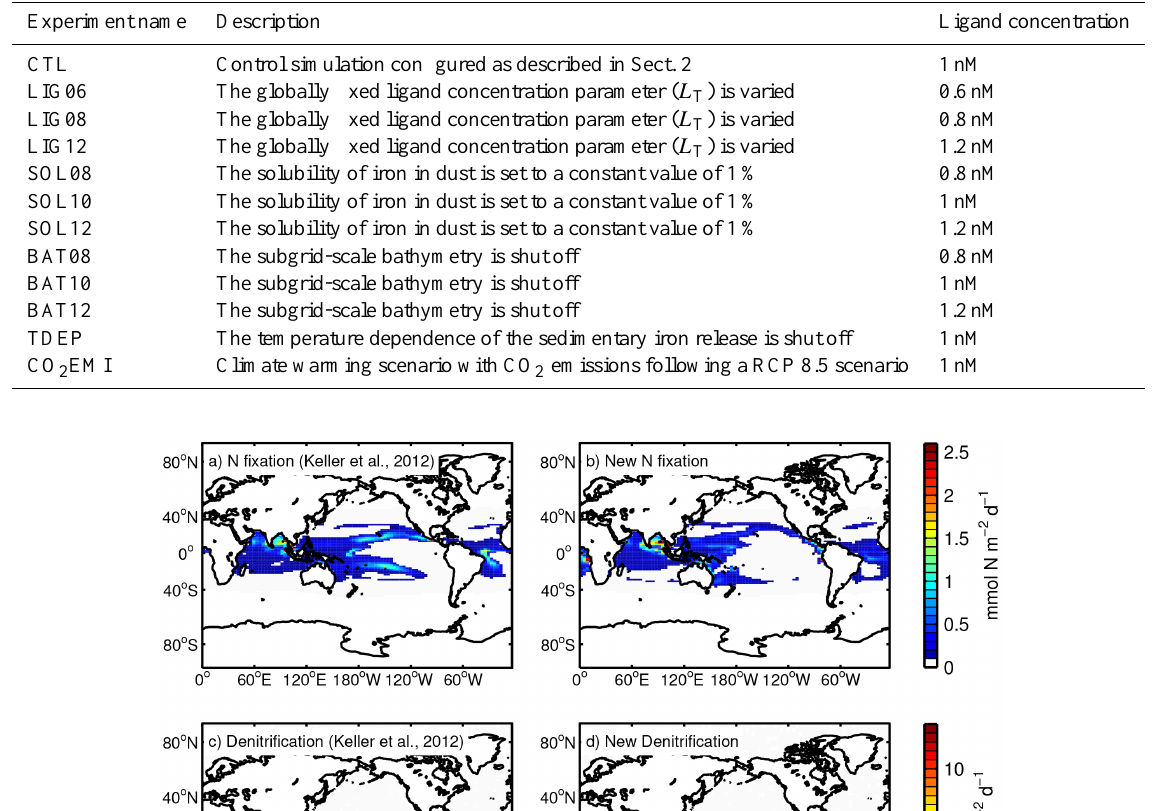
Table 2. Summary of the model experiments conducted with short name, description and the parameter value of the globally constant ligand concentration.